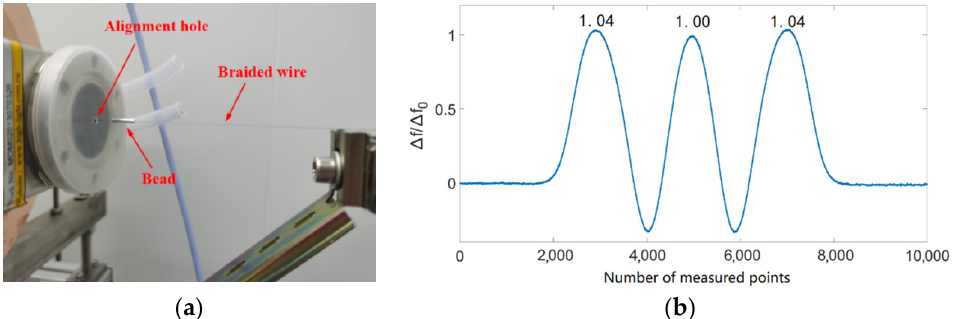
Figure 10. Bead-pull measurement device with measurement result. ( a ) The measurement device; ( b ) One of the measurement results.